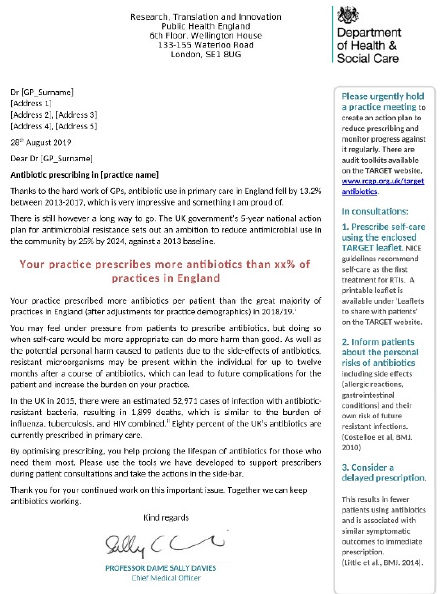
Figure 3. Example 2 of the workshop GP feedback letter with headline result in red at the top of the letter and three key action points boxed to the right of the main text.